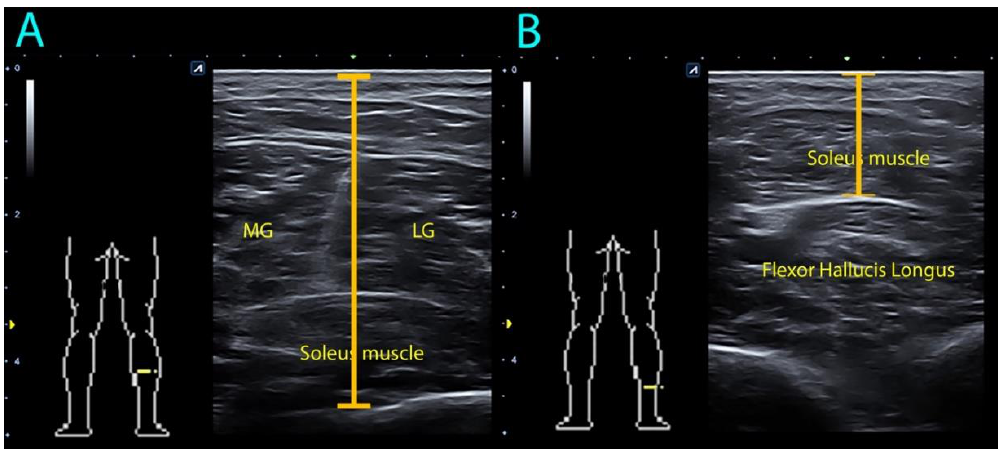
Figure 2. Ultrasound assessment of soleus muscle depth in the ( A ) mid-third and ( B ) distal-third of the calf. MG: medial gastrocnemius; LG: lateral gastrocnemius.